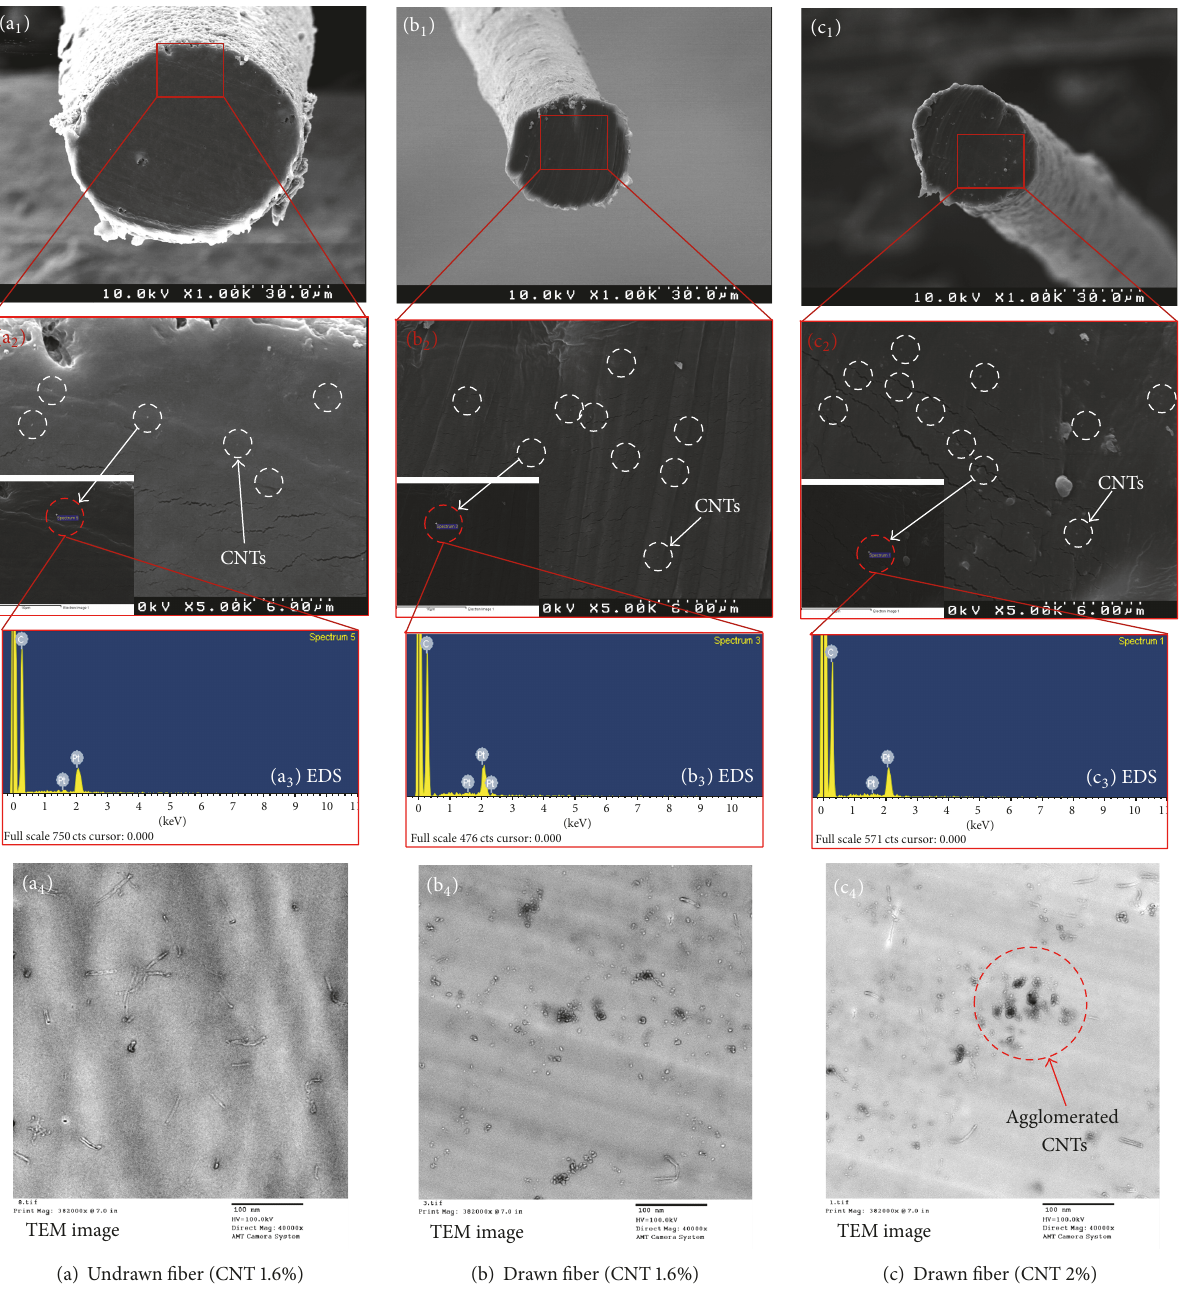
Figure 6: Cross-sectional SEM and TEM images of undrawn and drawn LLDPE fibers with CNTs 1.6wt.% and 2.0 wt.%: (a) undrawn LLDPE- CNT 1.6wt.%; (b) drawn LLDPE-CNT 1.6wt.%; (c) drawn LLDPE-CNT 2.0